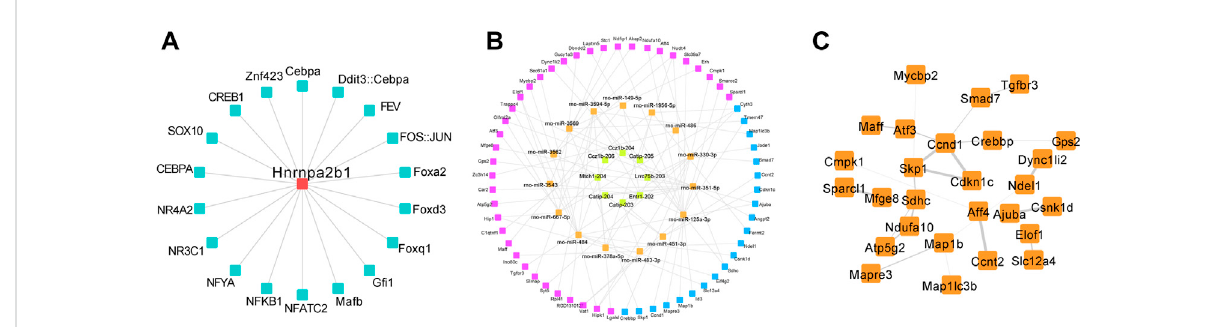
FIGURE 7 The HNRNPA2B1 – lncRNA/miRNA/mRNA interaction could promote the PASMCs phenotypic switch. (A) The predicted TFs